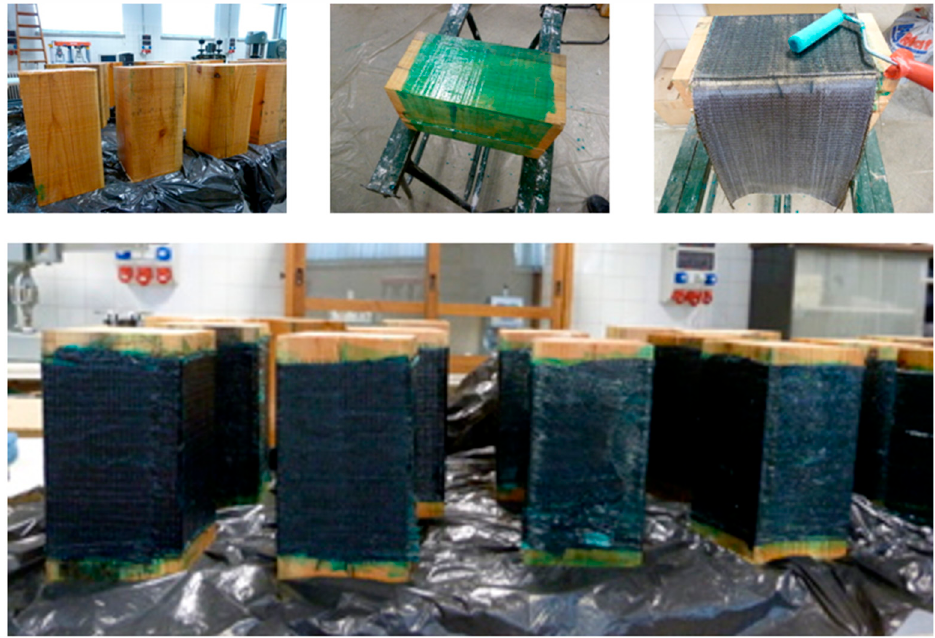
Figure 1. Process of reinforcing wooden pieces with carbon and basalt fibers.